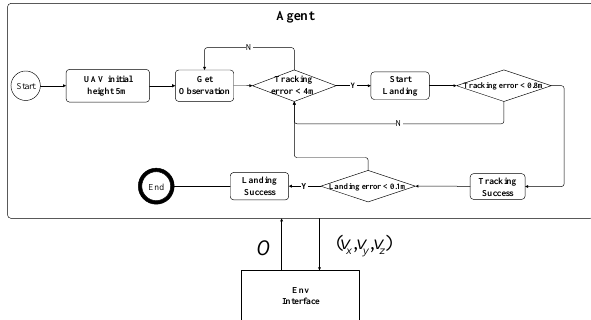
Figure 6. The simulation experiment includes two parts: the tracking and landing experiment. Once the UAV can track the moving target stably, it will adjust the altitude and land on the moving platform.